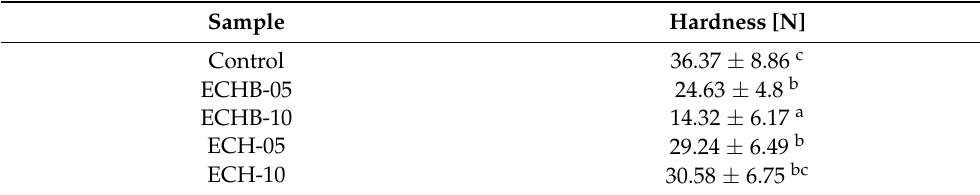
Table 7. Hardness of selected corn extrudates with addition of fruit